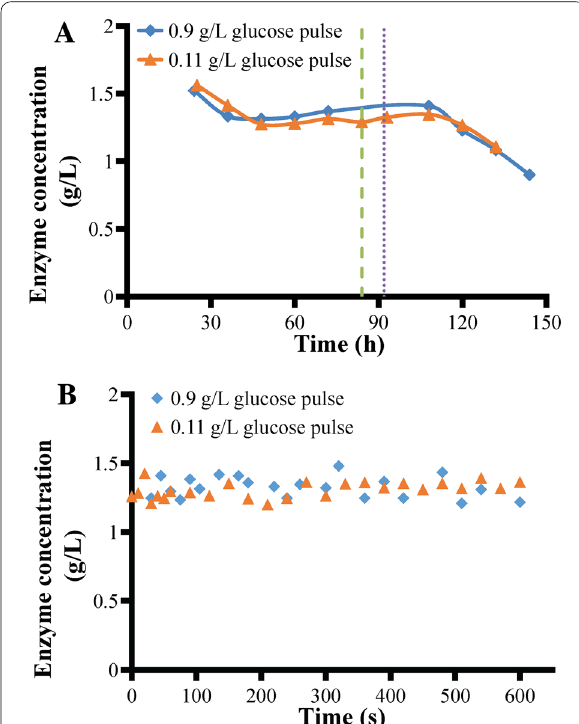
Fig. 3 a Profiles of the extracellular glucoamylase concentration over time; b extracellular glucoamylase concentrations during 10 min after the glucose pulses applied at 84 h of fermentation. Closed lozenges are for the 0.90 g/L glucose pulse experiment and closed triangles for the 0.11 g/L glucose pulse experiment. The meaning of the two vertical dashed lines is the same as Fig.